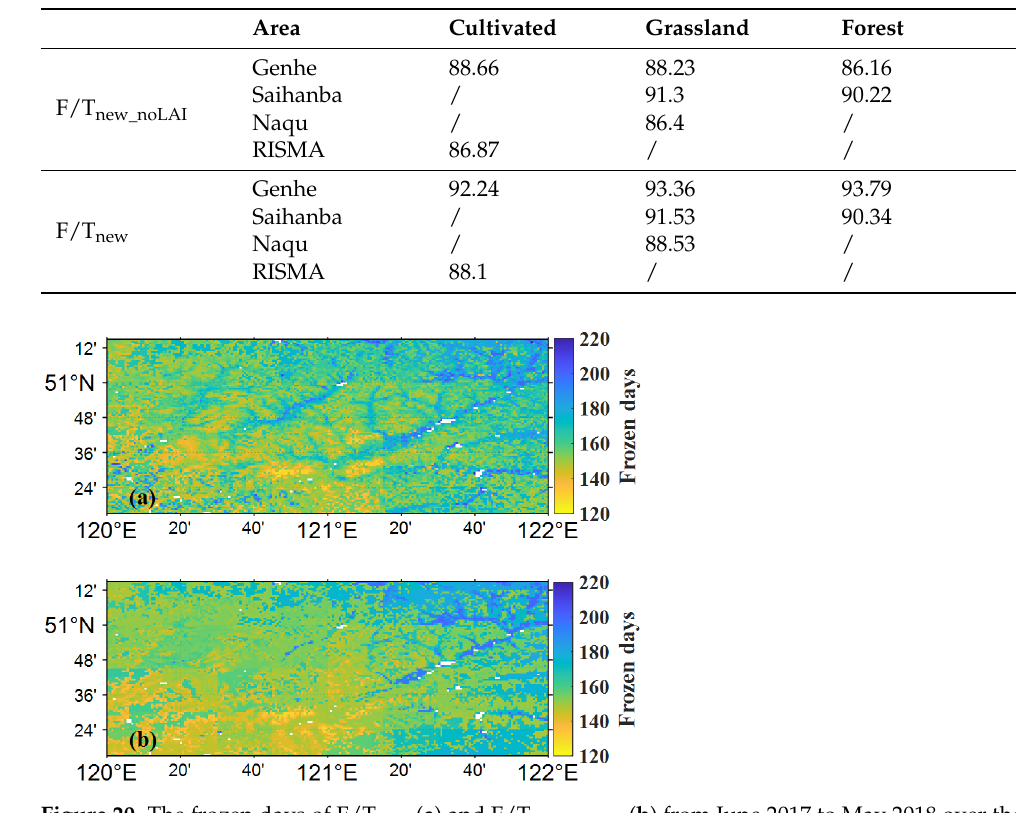
Figure 20. The frozen days of F/T new ( a ) and F/T new_noLAI ( b ) from June 2017 to May 2018 over the Genhe watershed area as an example.